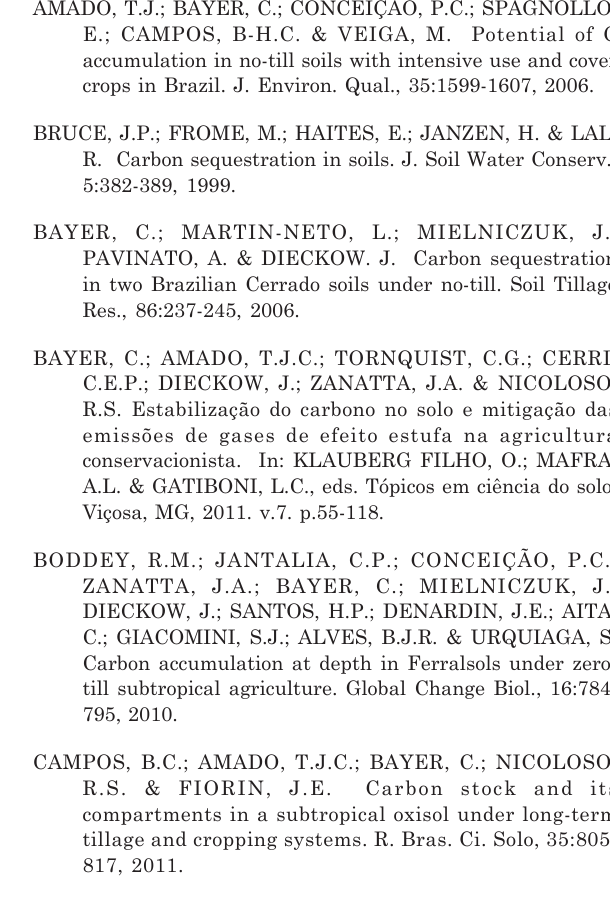
(1) Typic Hapludox (Oxisol), medium texture; (2) Typic Hapludox (Oxisol), clay texture. (3) Crop residue equivalent calculated by the equation CRE = sequestered C x 3.77 x 2.28, where sequestered C is the estimated annual rate of accumulated C, based on the Hénin & Dupuis (1945) model; 3.77 is the factor for the transformation of humidified C in the C inputs (1/0.265 = 3.77); 2.28 is the factor for the transformation of C input in crop residue (100/43.8 = 2.28); and 438 g kg -1 is the C content in the crop